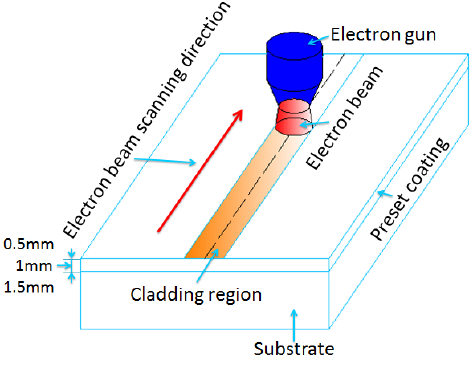
Figure 1. Schematic diagram of electron beam cladding.